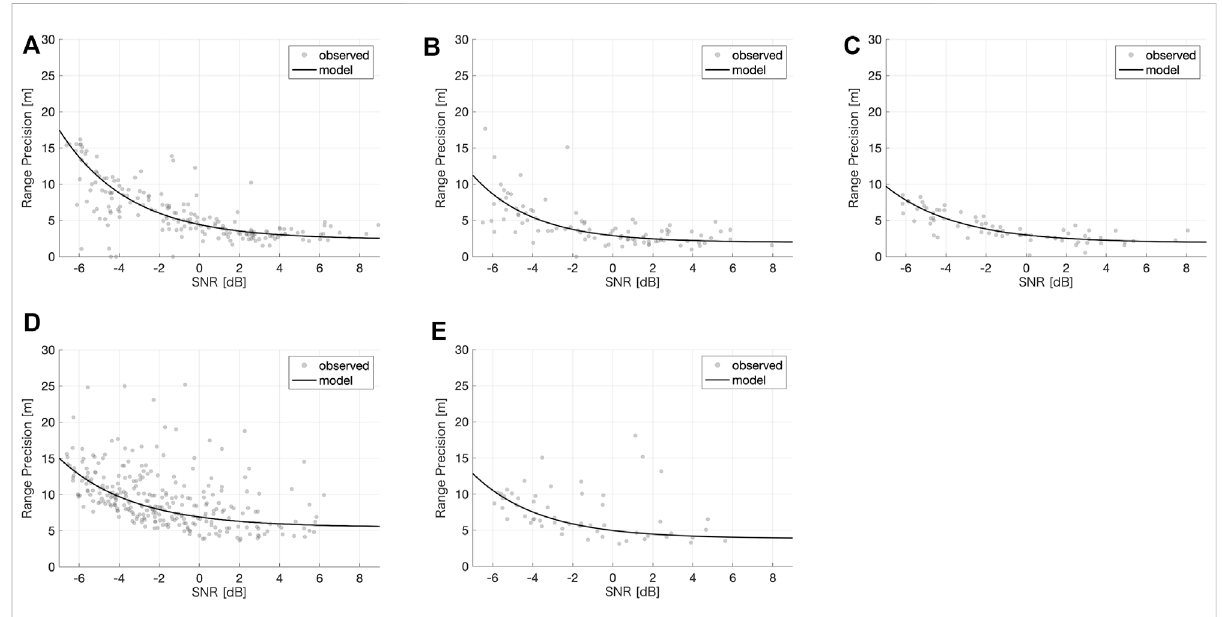
FIGURE 7 Observed ranging precision and the fi tted model of 2s measurements for fi ve groups: (A) for CY G , (B) for CY E , (C) for CY C , (D) for TDS G , and (E) for TDS E .